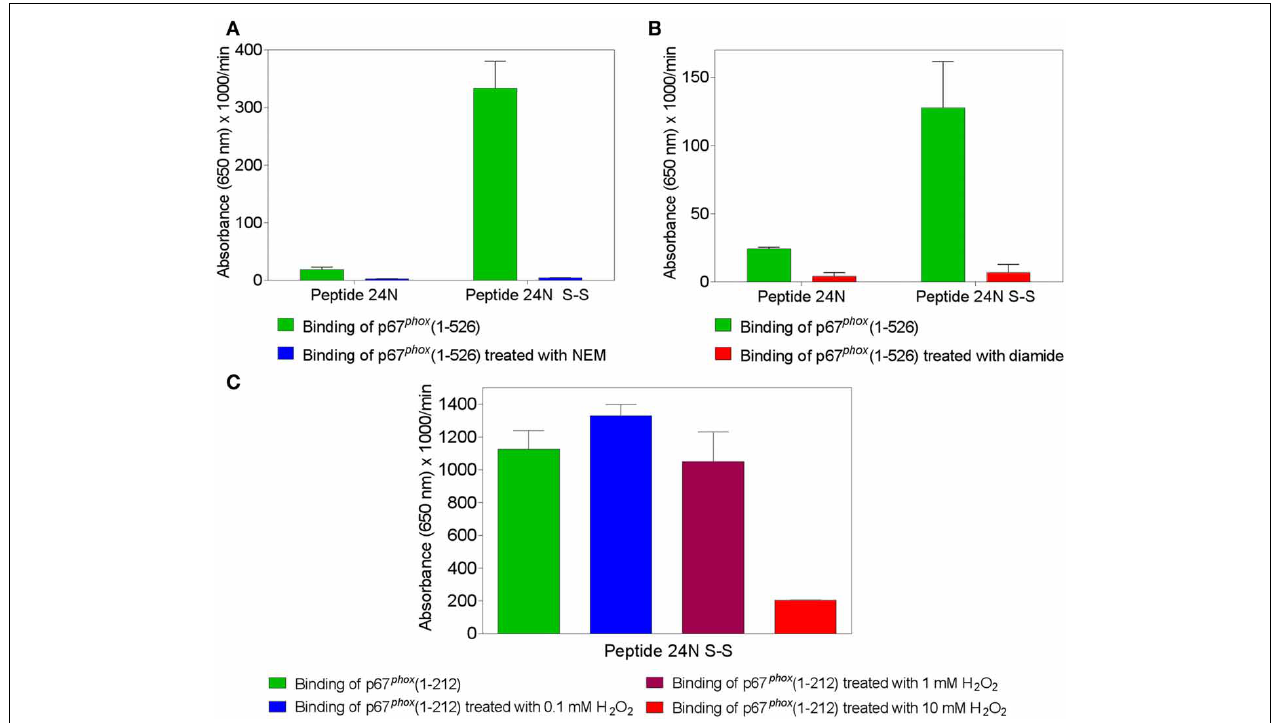
FIGURE 2 | Treatment of p67 phox with N -ethylmaleimide (NEM), diamide, or H 2 O 2 reverses the enhanced binding to Nox2 peptides containing an intramolecular disulfide bond. p67 phox (1–526) (1.5 μ M) was incubated with NEM (0.1mM) (A) or diamide (5mM) (B) , for 1h at room temperature. p67 phox (1–212) (1.5 μ M) was exposed to H 2 O 2 (0.1, 1, or 10mM) for 2h at 4 ◦ C (C) . Control preparations were